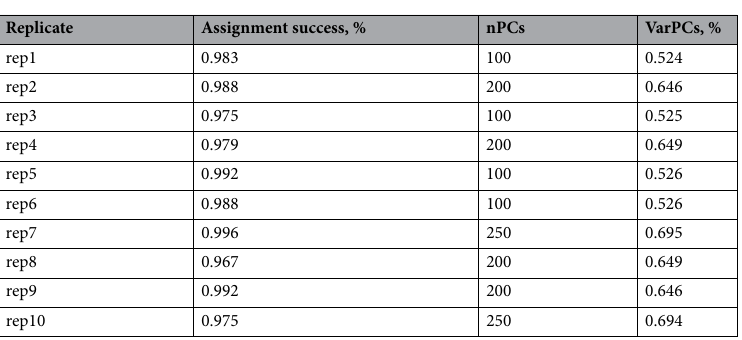
Table 2. Summary results of the DAPC model on the complete dataset. nPCs = number of principal components selected for the DAPC model; VarPCs = percentage of original variance explained by the selected principal components. The total number of pigs was 1,186, the number of pigs in the TRN set was 944, and the number of pigs in the validation set was 242.